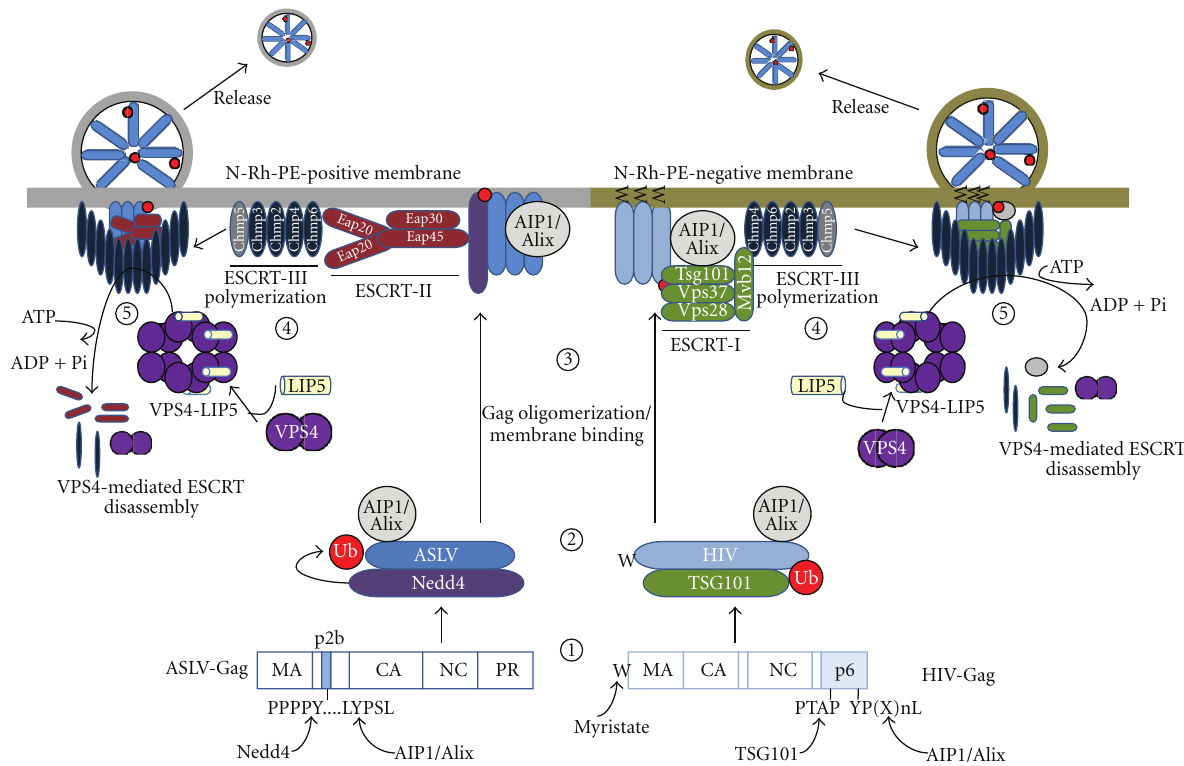
Figure 1: Parallel pathways used by ASLV and HIV-1 Gag to bud from cells. Retroviruses recruit components of the ESCRT machinery to assemble budding complexes. Step 1: HIV-1 and ASLV Gag L-domains bind to Tsg101 and Nedd4, respectively. They also bind the Alix adaptor protein. Whether these initial interactions take place in the cytosol or at the plasma membrane remains to be defined. Step 2: Nedd4 mediates ubiquitination of ASV Gag. HIV-1 Gag is ubiquitinated by an unidentified E3 ligase. Step 3: Gag oligomerization in the cytosol increases membrane avidity and in conjunction with the M domain signal at the N-terminus of Gag targets the polyproteins to sites of assembly/budding on the plasma membrane. ASLV Gag assembles on rhodamine labeled phosphatidylethanolamine (N-Rh-PE)-positive, endosome-derived membranes. HIV-1 Gag assembles on N-Rh-PE-negative membranes. Step 4: The ASLV Gag/Nedd4/Alix complex recruits ESCRT-II proteins while the HIV-1 Gag/Tsg101/Alix complex recruits the remainder of the ESCRT-I proteins. Each early budding complex then recruits the same ESCRT-III machinery which promotes the membrane scission to release VLPs from the cellular membranes. Step 5: The ESCRT-III subunits recruit the AAA ATPase, VPS4, and the coactivator protein LIP5 to mediate the disassembly of membrane-bound ESCRT complexes concomitant with the budding